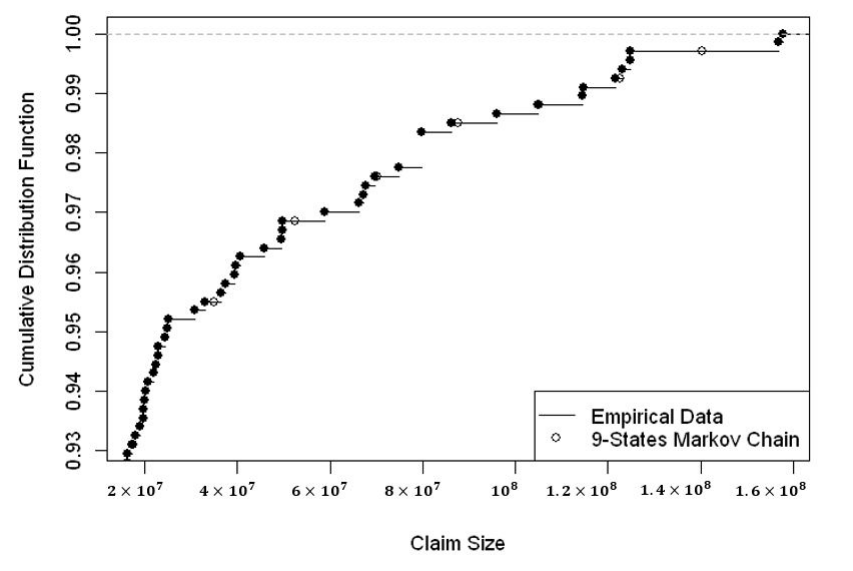
Figure 11. Distribution function of empirical data and 9-states Markov Chain for Group 1 [ ˆ D 1 ( g )